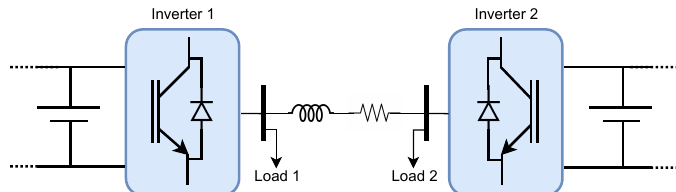
Figure 1. Interconnected inverters.